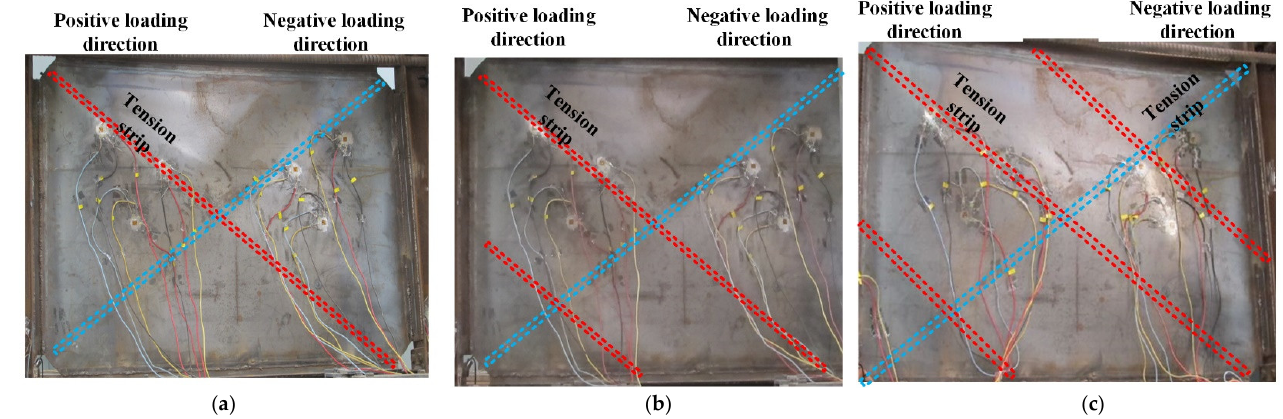
Figure 9. Performance of specimen SPSW: ( a ) loading displacement ∆ y ; ( b ) loading displacement 1.9 ∆ y ; ( c ) loading displacement 2.4 ∆ y . Table 3. Details of characteristic